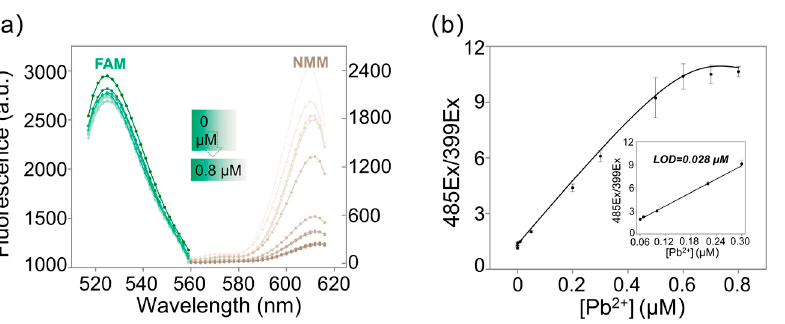
Figure 4. Quantitative experiment of Pb 2+ with the proposed assay. ( a ) Fluorescent spectrum collected at 521 nm (FAM, excited at 425 nm) and collected at 612 nm (NMM, excited at 399 nm) respectively. 0, 0.0001, 0.001, 0.01, 0.05, 0.2, 0.3, 0.5, 0.6, 0.7 and 0.8 µ M Pb 2+ were added, respectively. ( b ) The relationship between Pb 2+ concentration and 485Ex/399Ex; (Insert) 485Ex/399E showed a linear relationship with the increase of Pb 2+ .